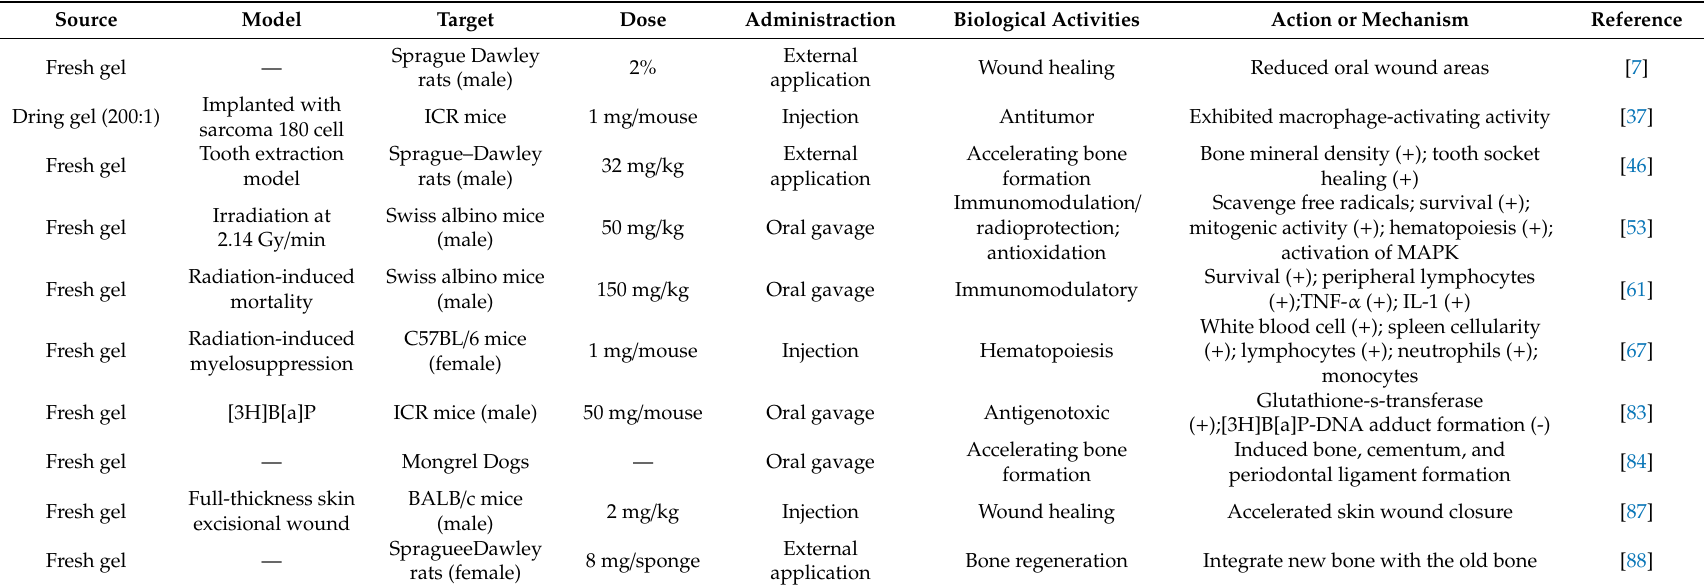
Table 3. Biological activity of acemannan in